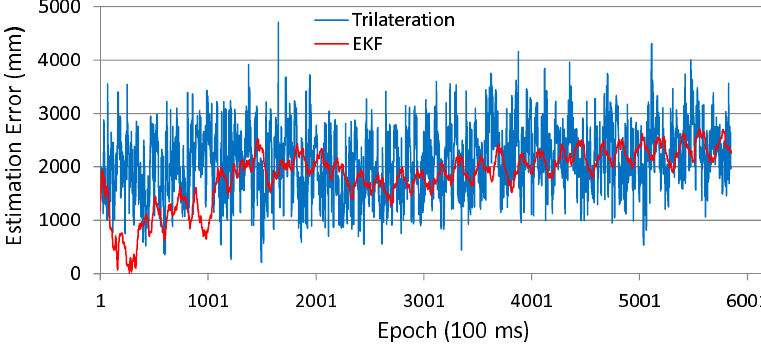
Figure 14. Position estimation error (experiment with human).